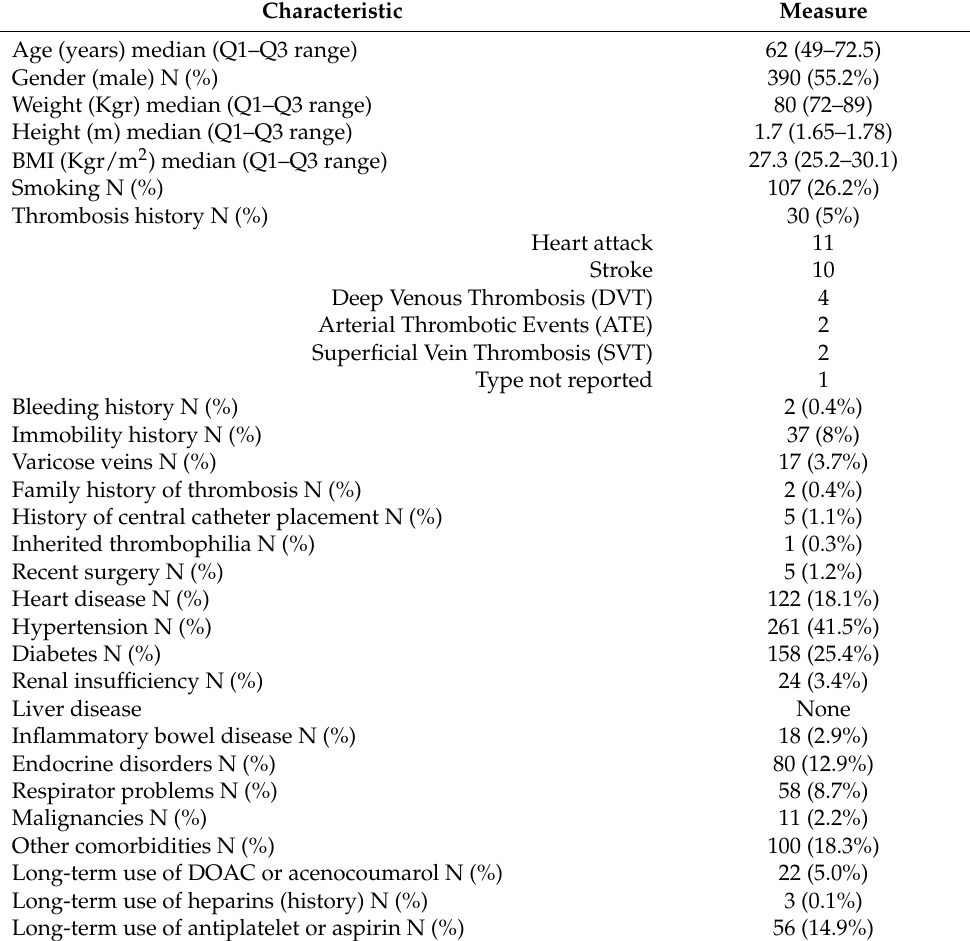
Table 1. Demographic data, past medical history, and anticoagulant treatment prior to admission of the study population.